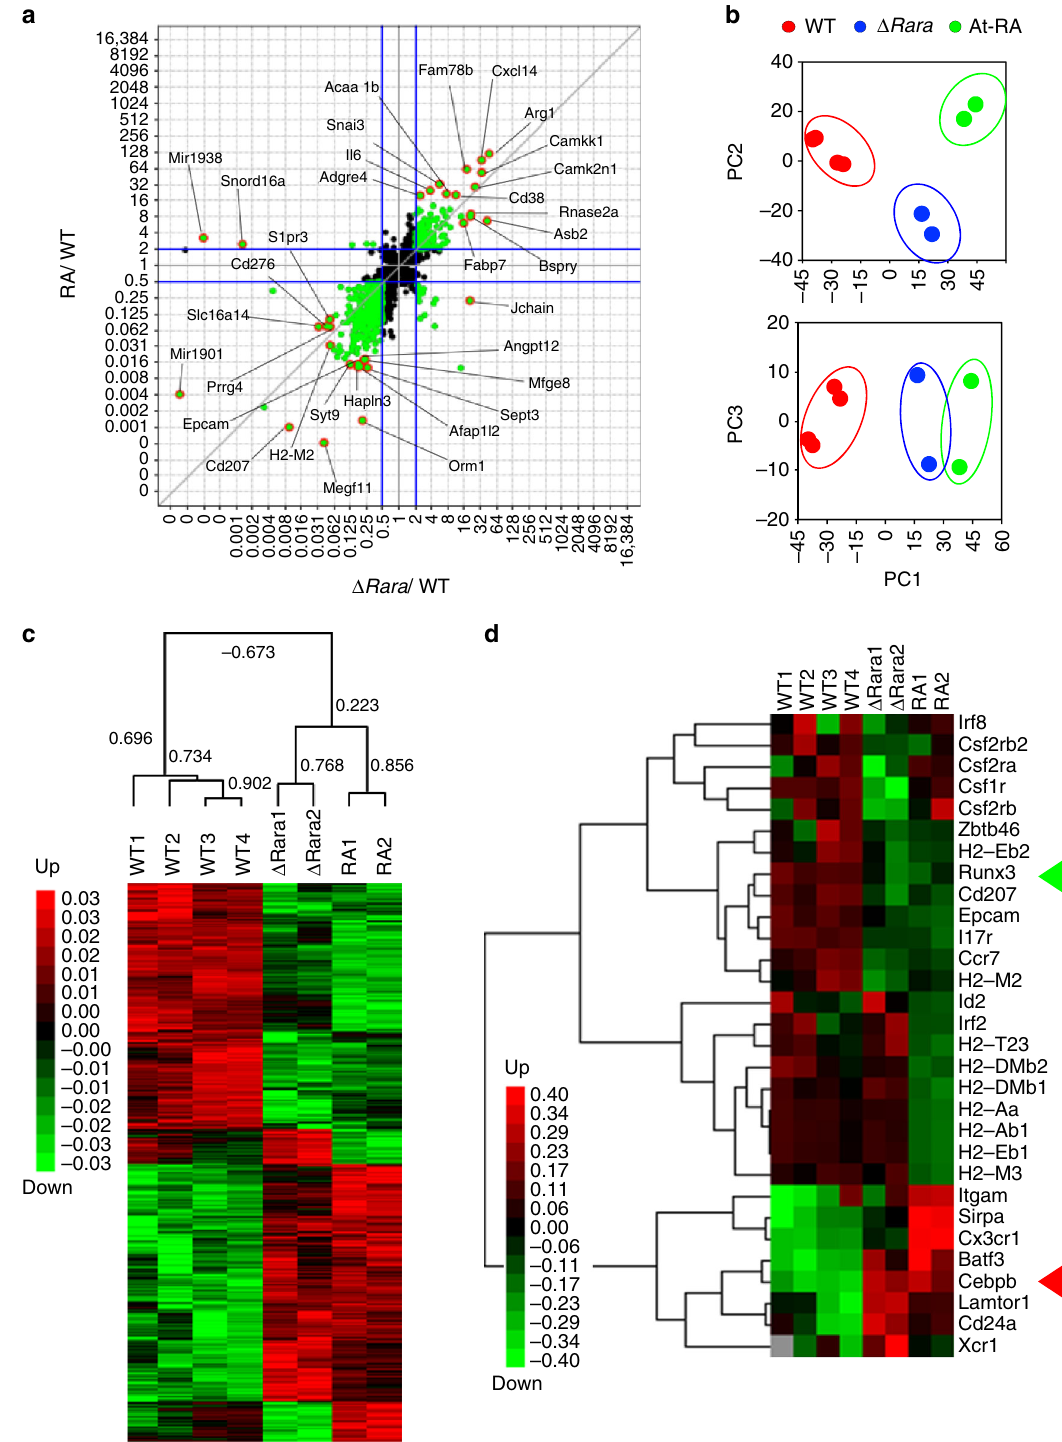
Fig. 4 The effects of RAR α de fi ciency vs. RA on gene expression in BM-derived DCs cultured in a LC-inducing condition. For all panels in this fi gure, RNA- seq was performed on WT and Δ Rara CD11c BM cells cultured in charcoal-treated FBS medium containing GM-CSF and TGF β 1 for 3 days. WT cells were cultured with or without At-RA (10 nM). 2 – 4 independent samples were examined for each group. a Scatter plot analysis of RPKM (Reads Per Kilobase of transcript per Million mapped reads) values for Δ Rara CD11c vs. WT for X -axis and RA vs. WT for Y -axis. 2619 differentially expressed genes were selected based on T-test ( P < 0.2) adjusted with Benjamini – Hochberg procedure of the Multiplot Studio (Version 1.5.29, GenePattern). Total 8 samples were examined by RNA-seq (4 WT, 2 Δ Rara CD11c , and 2 At-RA). Genes highlighted in orange are the top 10 up- or down-regulated genes. b Principal component analysis (PCA) of the 2619 selected genes based on their RPKM values. c A Treeview showing hierarchical clustering of 2619 genes commonly or differentially regulated in BM-derived DCs cultured in a LC-inducing condition. Pearson correlation indices are shown. d A Treeview showing hierarchical clustering of manually selected genes from the differentially regulated 2619 genes. The green and red triangles respectively highlight Runx3 and Cebpb genes. Error bars are de fi ned as